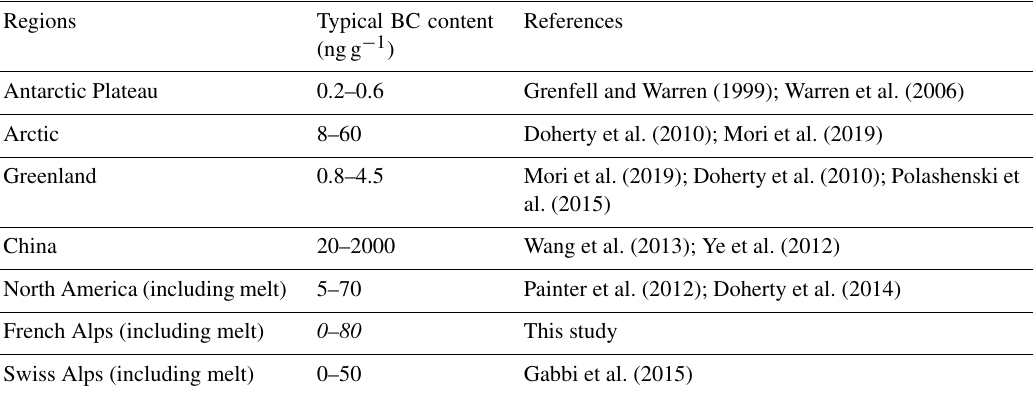
Table 2. Typical surface concentration of black carbon measured in different regions of the world. The result of this study are presented in